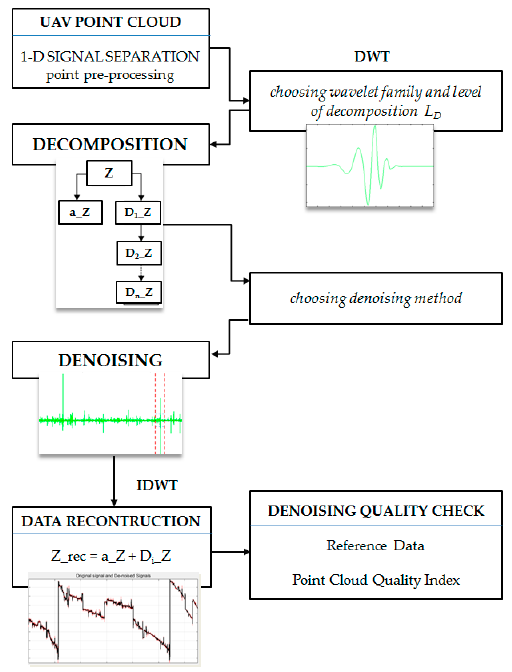
Figure 8. Data denoising workflow, Z—vertical coordinate of UAV imagery point clouds, D i —details; a_Z —approximation of the Z coordinate.